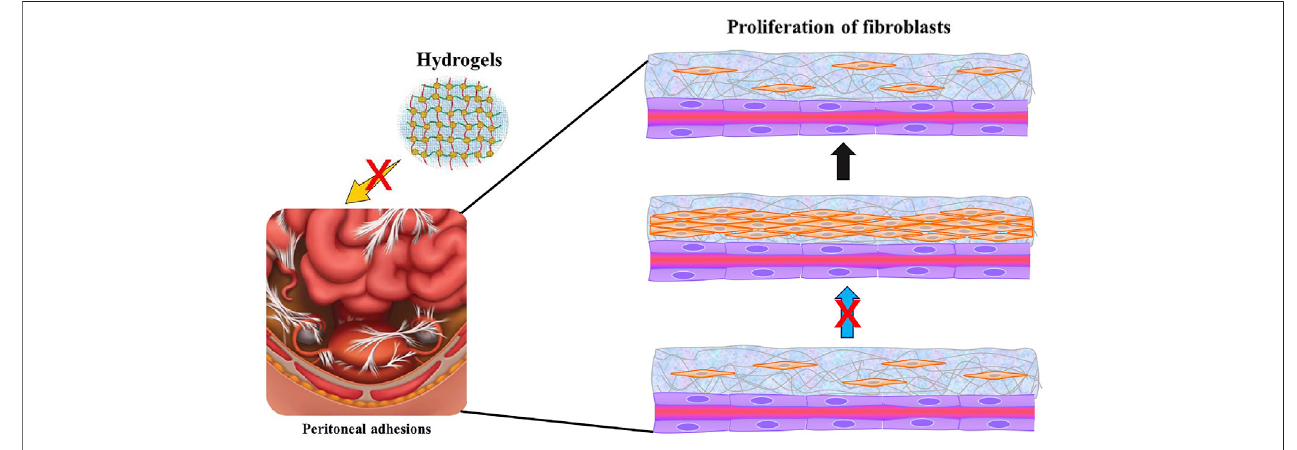
FIGURE 3 | Schematic diagram of injectable anti-adhesion hydrogel.